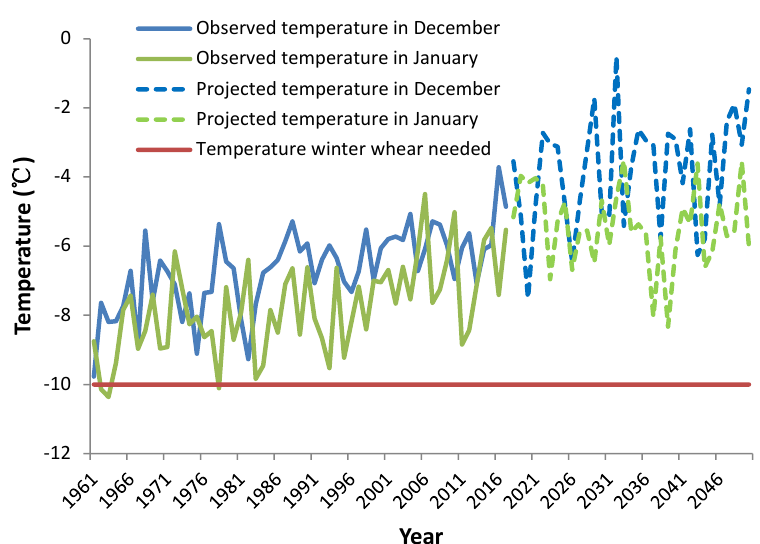
Figure 5. The change of monthly temperatures over the wheat area in December and January during the periods 1961 – 2017 (observed) and 2018 – 2050 (projected) from RegCM4. The yields of spring wheat can amount to 3000 – 4500 kg/ha, while the yields for winter wheat are more than those of spring yields. This indicates that farmers could produce more wheat if winter